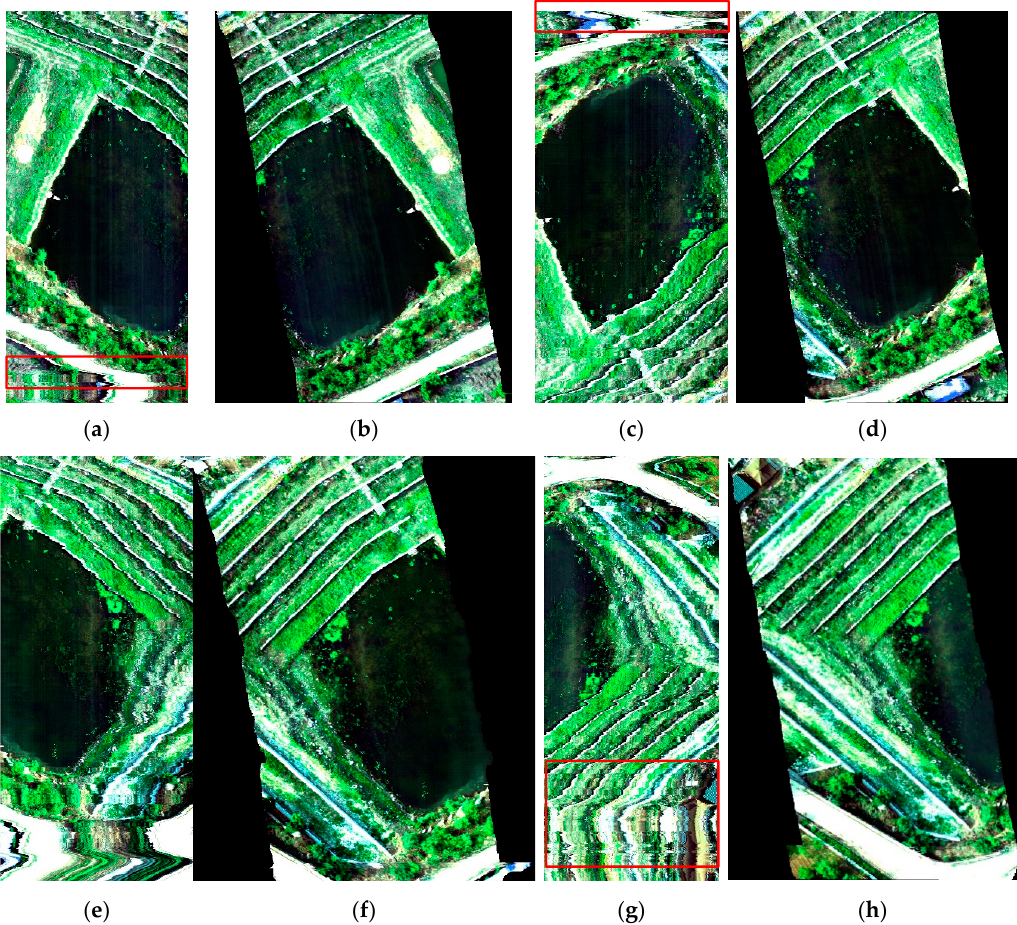
Figure 6. Four flight image strips ( a , c , e , g ) before and ( b , d , f , h ) after georeferencing shown in true color with infrared, red, and green bands. Figure 6b,d,f,h show the results of rotating the georeferenced images clockwise by 350.64°, 349.11°, 348.35°, and 348.80°, respectively.. The red rectangles show the severe distortion area in each flight strip.